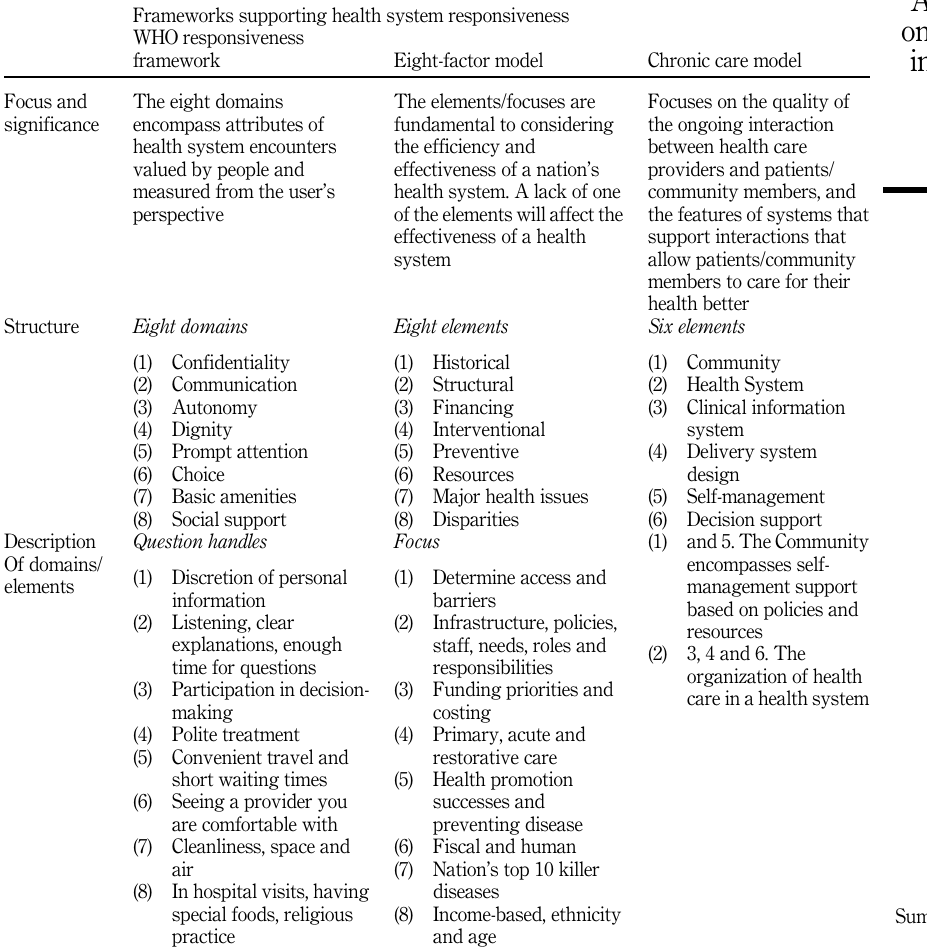
Table 1. Summary